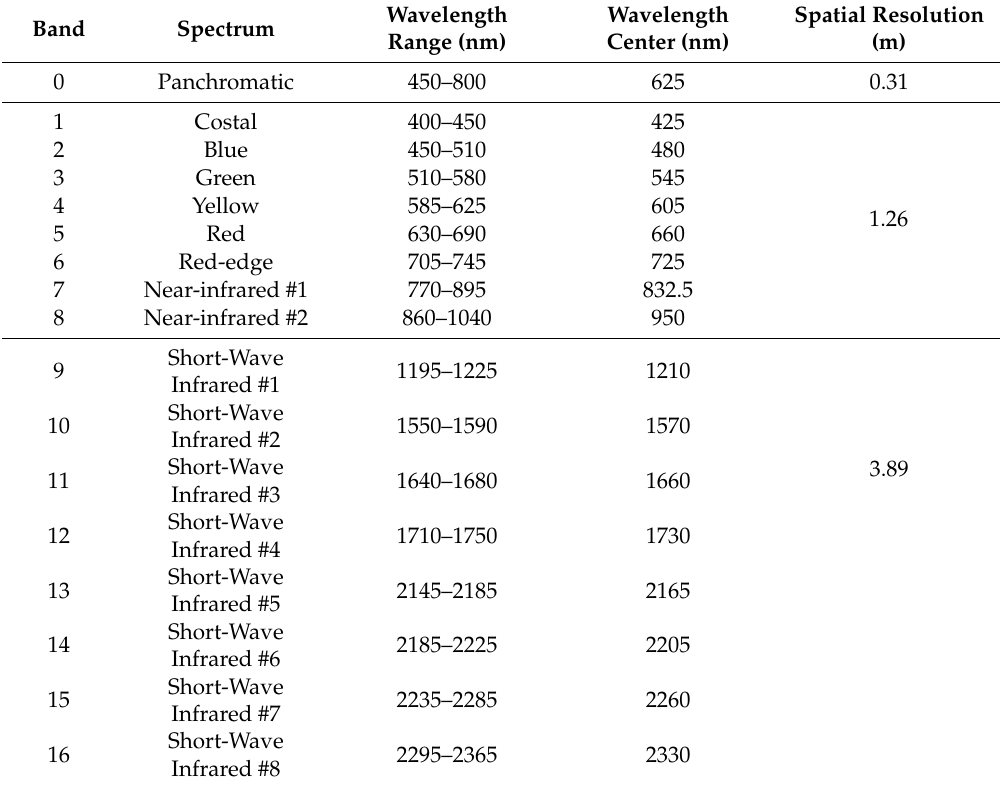
Table 1. WorldView-3 channels